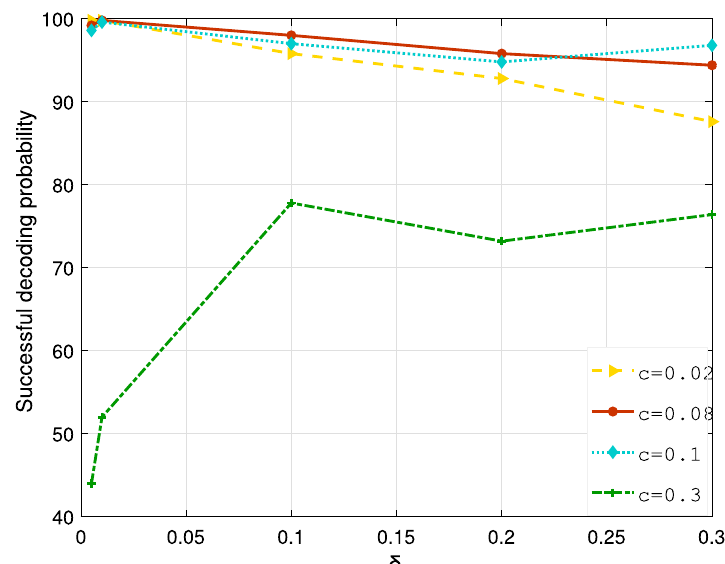
Fig. 5 Successful decoding probability with PRSD for different c and δ